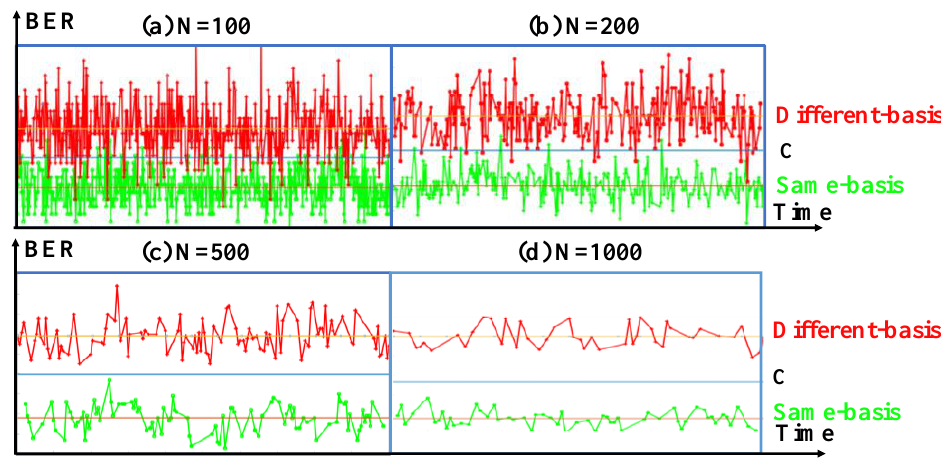
Figure 8. BER variation curves of same-basis and different-basis.